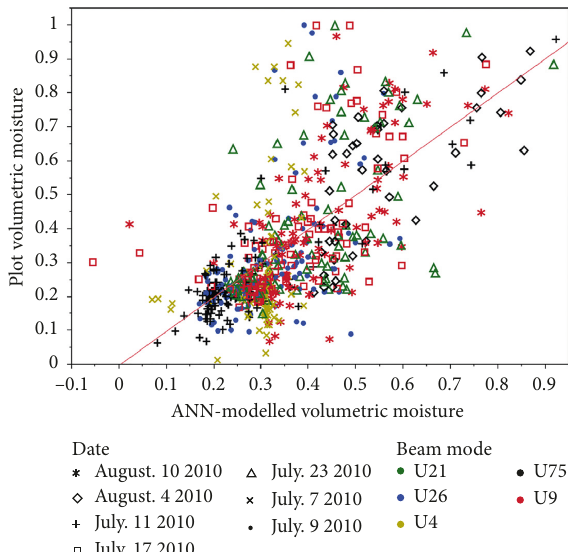
Figure 7: Combined ANN output for each 2010 date, after scaling the